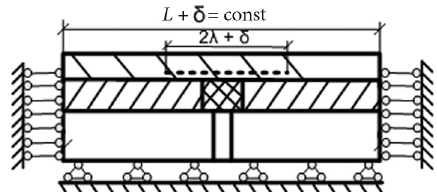
Fig. 6. Design model for the calculation of stresses in asphalt concrete pavement after repairing activities after sealing cracks of a small width in the top layer of asphalt concrete pavement on a solid base